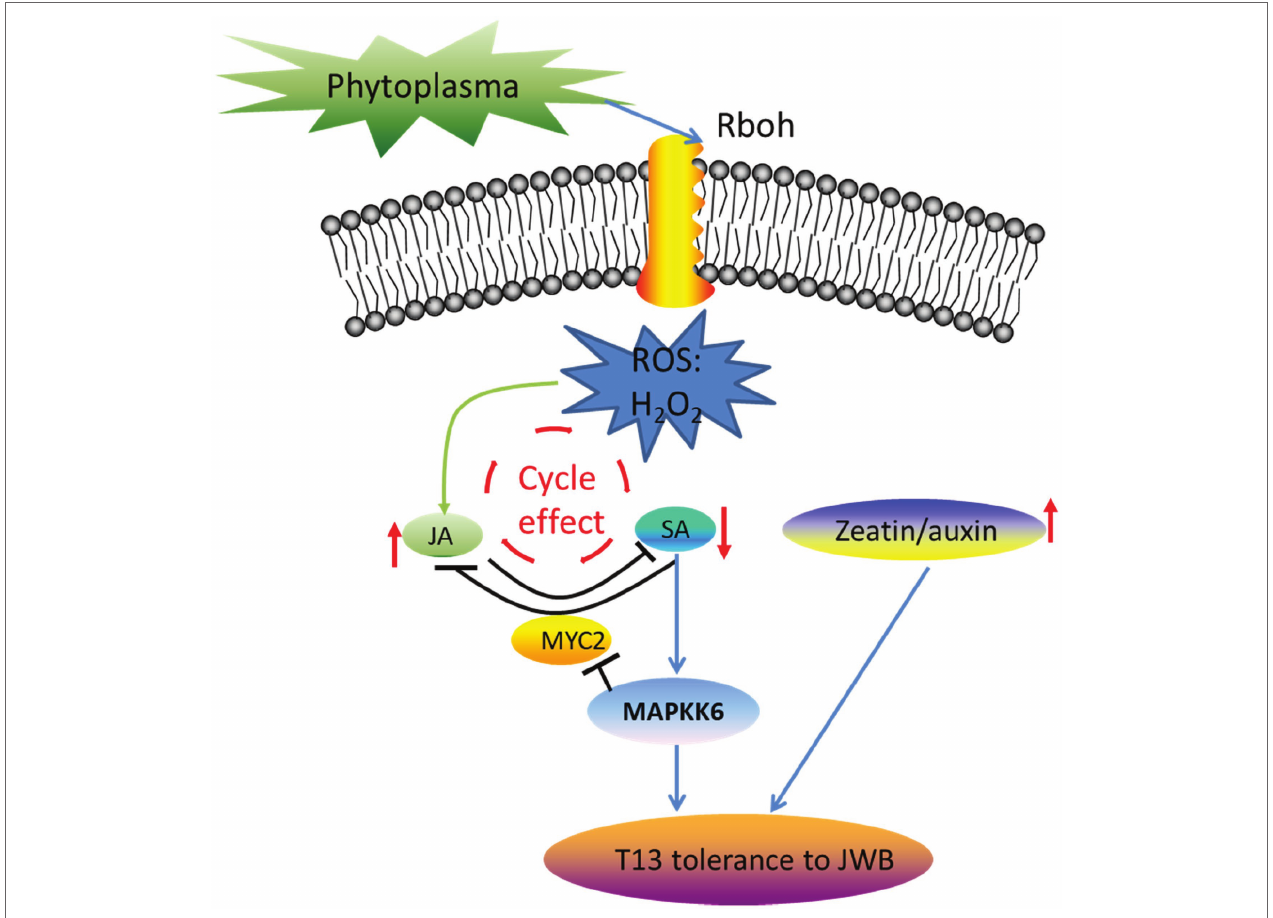
FIGURE 10 | The working model of how Chinese jujube “T13” resisted phytoplasma infection. Phytoplasma infection induces rapid ROS generation, which may be the initial signaling molecule to amplify the accumulation of JA, which could be further antagonistic to SA accumulation to decrease its contents. In addition, the cycle effect between ROS and JA/SA functions to amplify signaling. Moreover, lower contents of SA could shut down the upregulation of MAPKK6 , which could downregulate the expression level of MYC2 to inhibit the JA signal and activate the expression of downstream genes to confirm phytoplasma resistance. Another pathway is that a higher level of the ratio of zeatin to auxin contributes to phytoplasma resistance. The red arrow indicates the increase or decrease in the corresponding